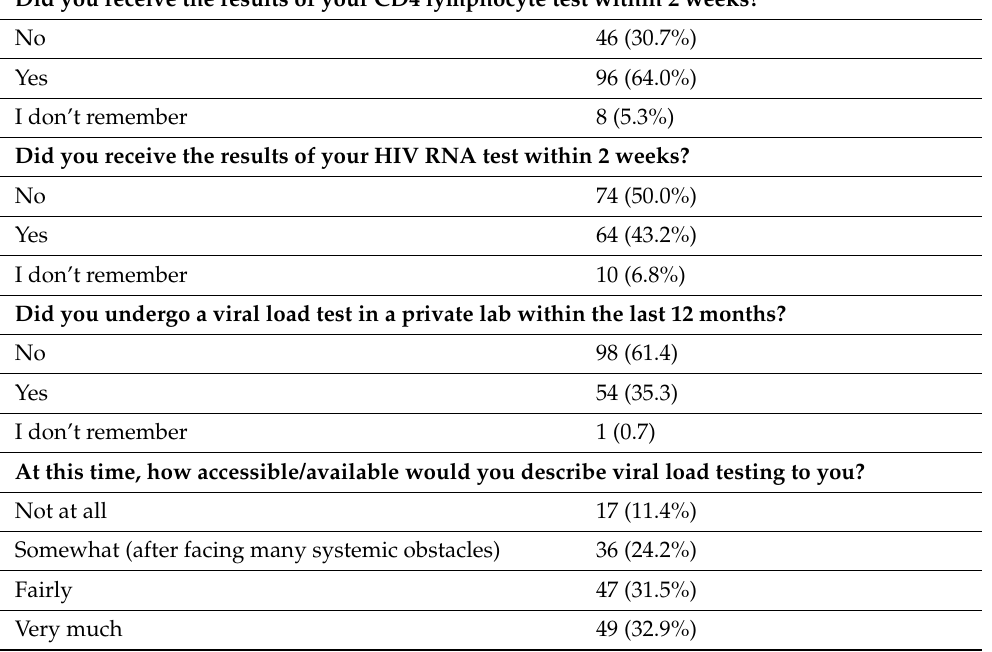
Table 3. Patient responses on most recent testing results.